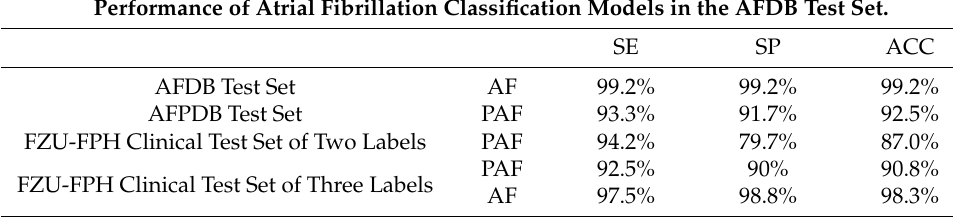
Table 9. Performance of different models in different test sets. Performance of Atrial Fibrillation Classification Models in the AFDB Test Set.